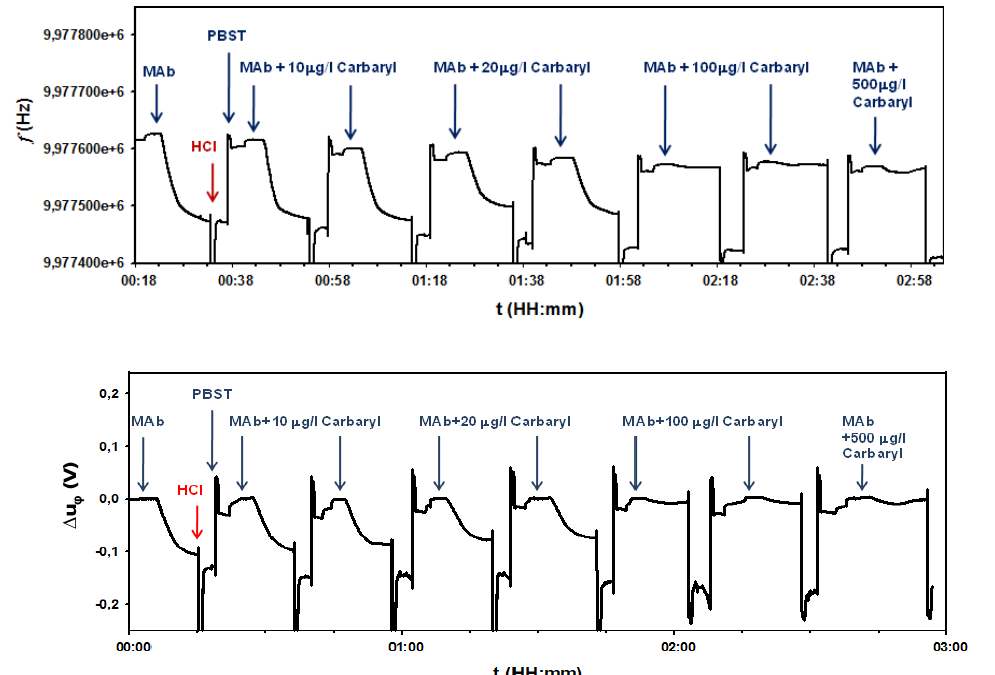
Figure 7. Real time piezoelectric immunosensor response to different concentrations of analyte: with the balanced-bridge oscillator (upper panel), and with the phase-shift characterization system (lower